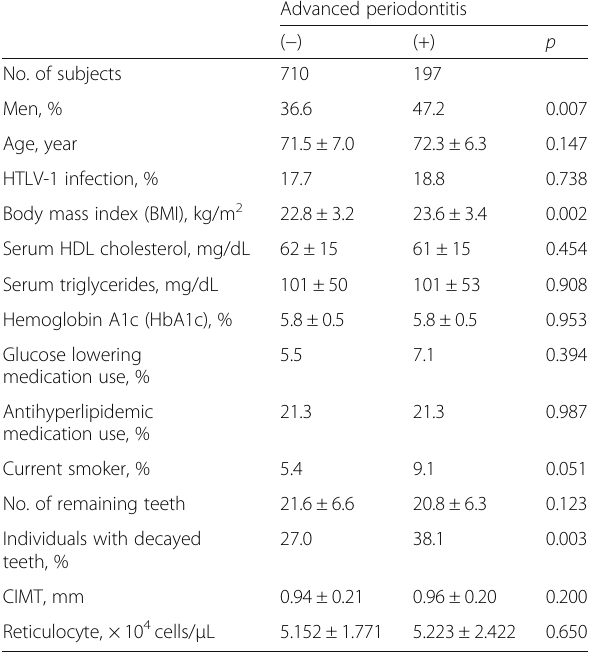
Table 2 Characteristics of the study